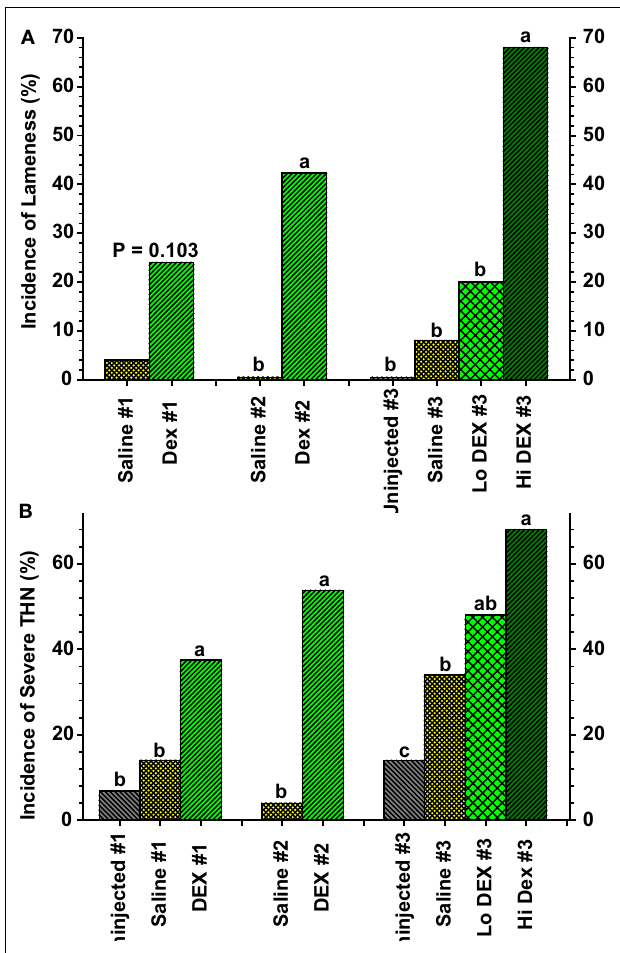
FIGURE 8 | (A) Incidence of lameness as a percentage of the total number of birds per group for broilers in three experiments (#1 through #3) that received three (Saline #1, DEX #1) or six (Saline #2, DEX #2, Saline #3, Lo DEX #3, Hi DEX #3) injections of saline or dexamethasone (DEX). (B) Incidences of “severe” tibial head lesions for the uninjected and saline- or dexamethasone-injected broilers are compared in three experiments. Lesions that obviously had damaged the growth plate per se , or that contained caseous exudates, were recorded as being “severe.”Values reflect the percentages of all legs evaluated; within each group the data for lame birds and survivors are pooled. a,b,c Values differed between the groups within an experiment ( P < 0.05; Z -test; adapted fromWideman and Pevzner,